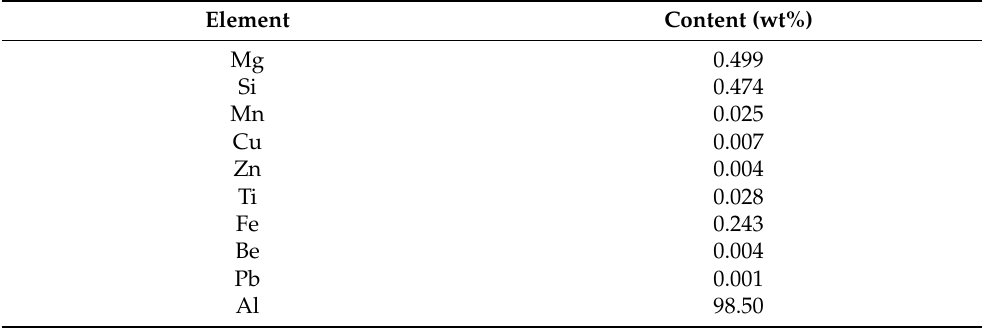
Table 1. Chemical composition of 7205